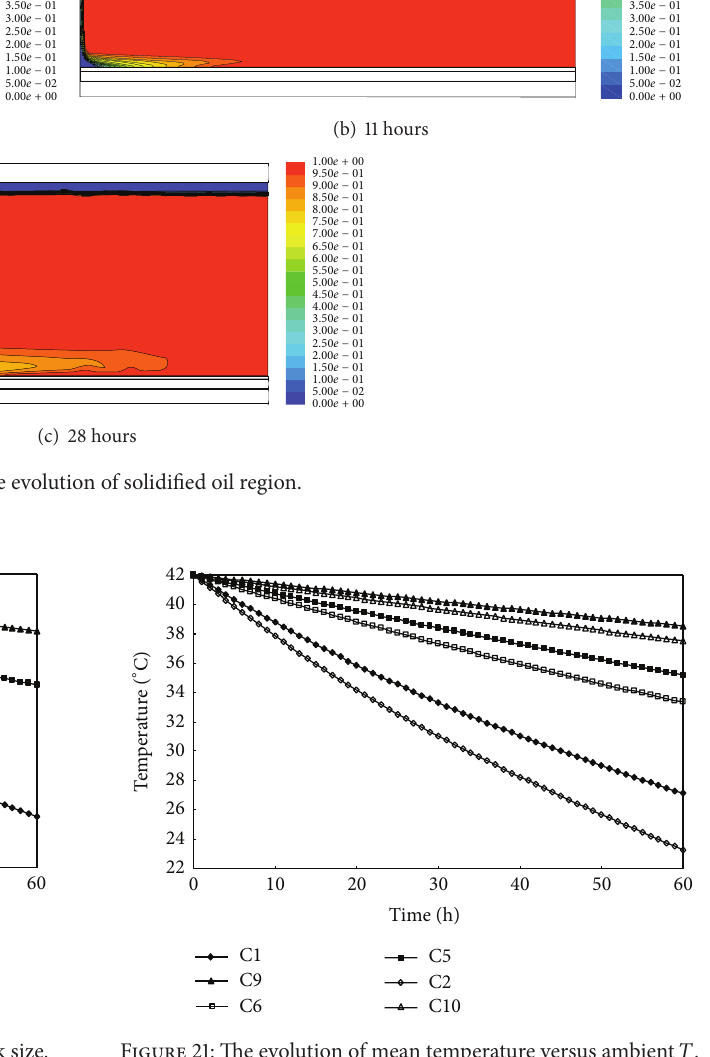
Figure 20: The evolution of mean temperature versus tank size. Figure 21: The evolution of mean temperature versus ambient 𝑇